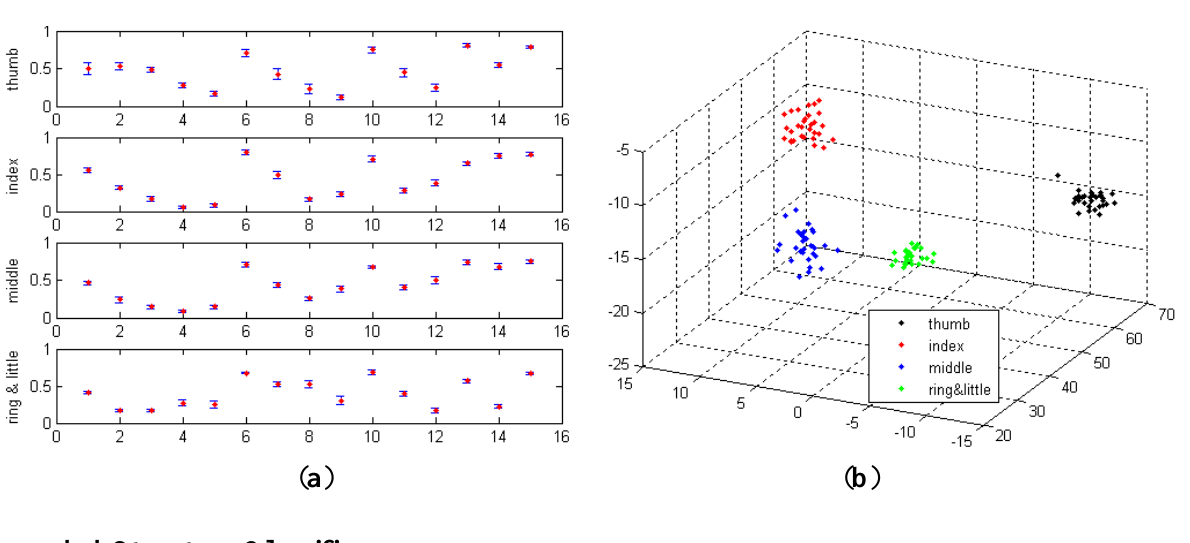
Figure 7. ( a ) Raw concordance correlation features of the four gestures. ( b ) Projected concordance correlation features of the four